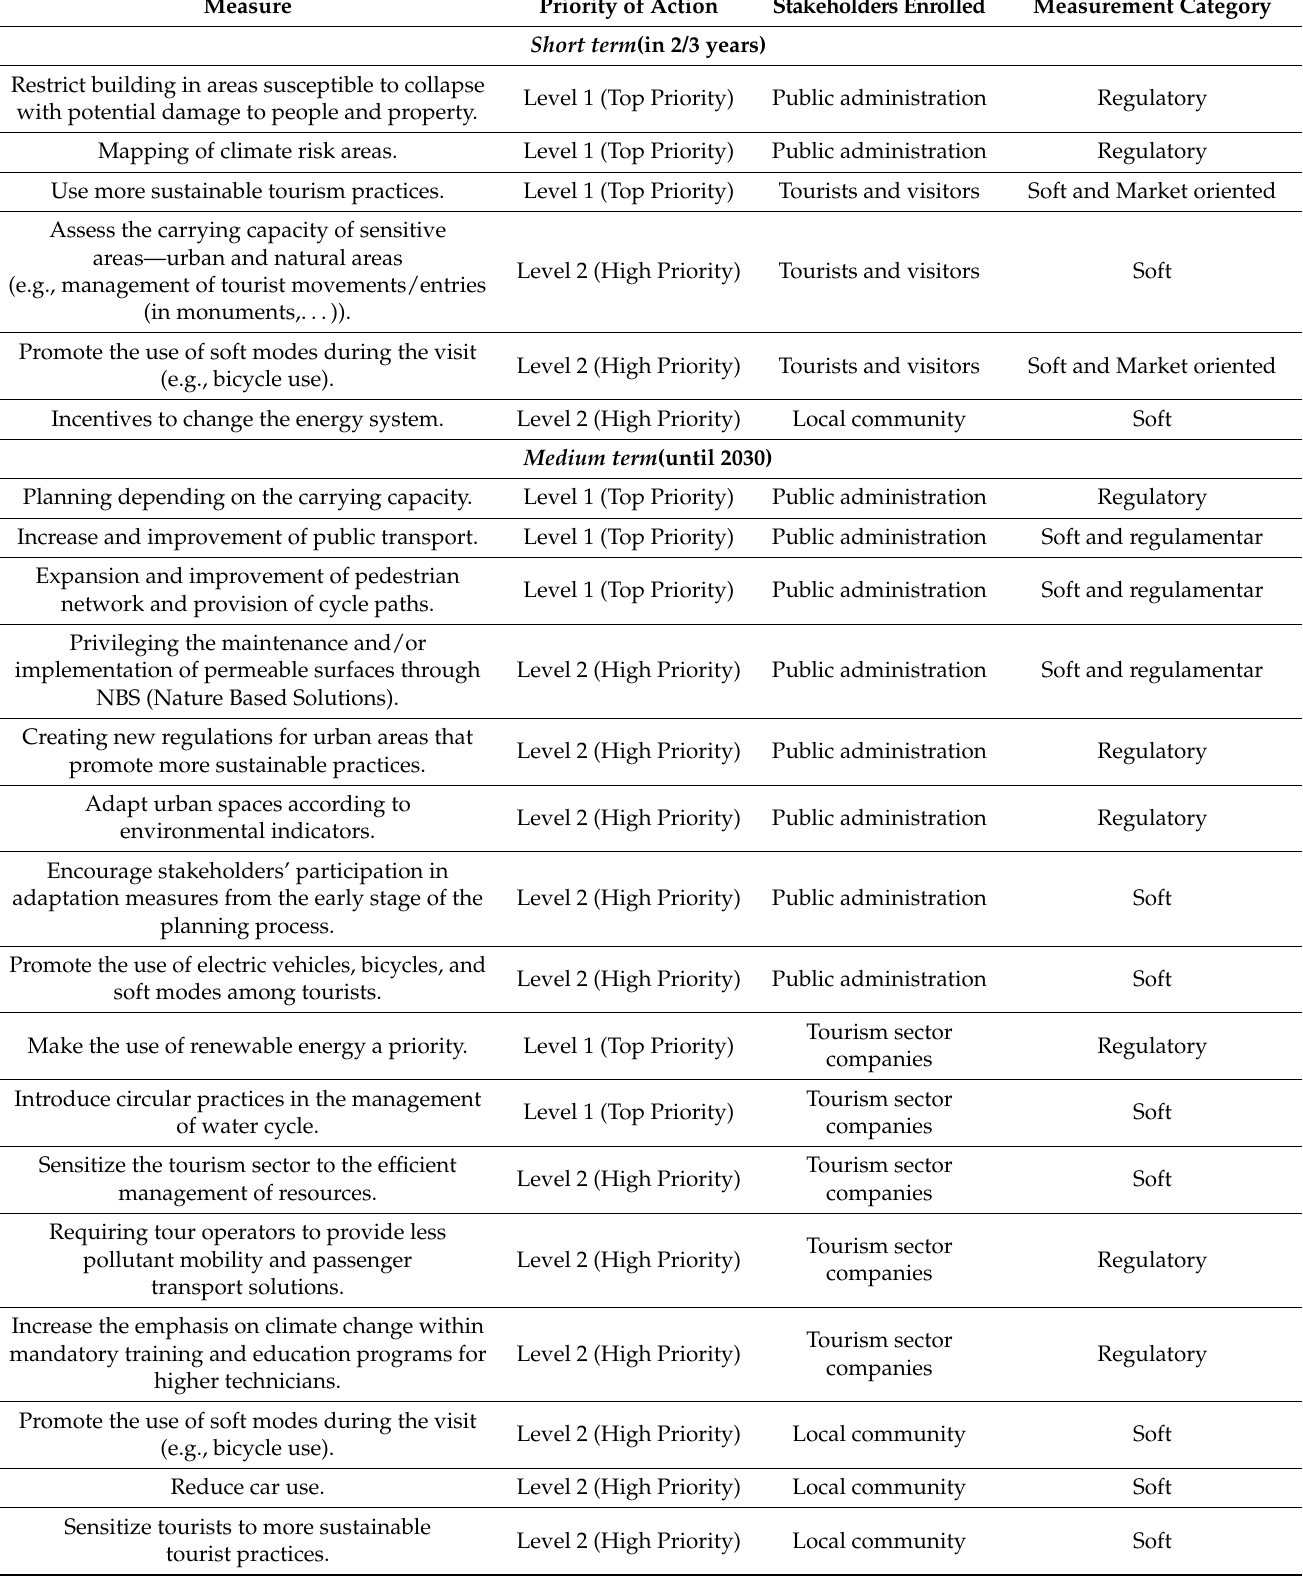
Table 4. Main measures identified by experts for the adaptation of the urban tourism sector to climate change in PMA—priority of action, stakeholders enrolled and measurement